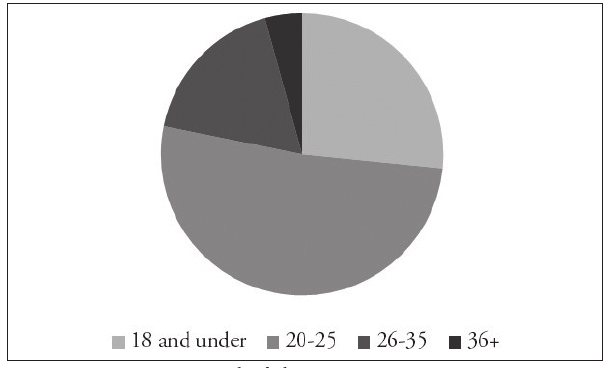
Figure 1: Minimum age eligibility requirements